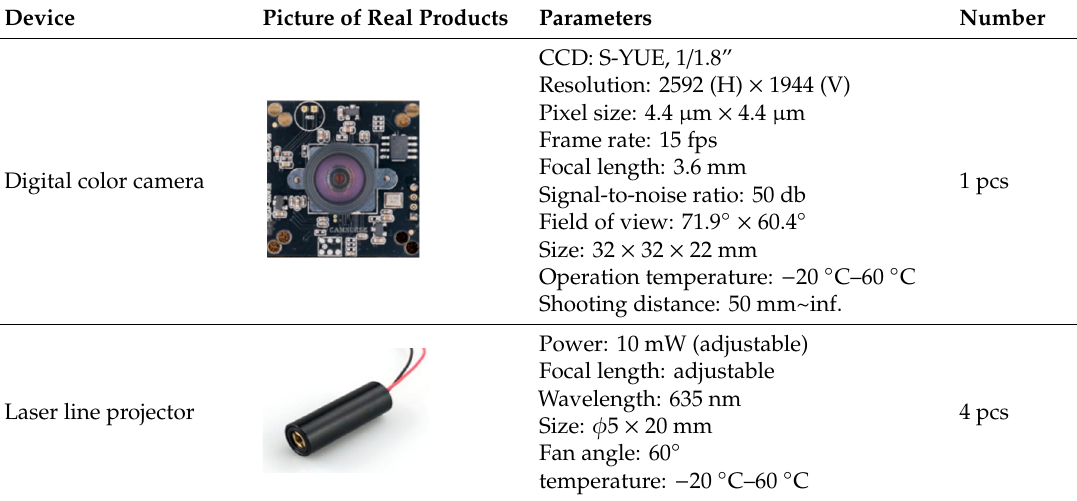
Table 1. Detailed parameters of the experimental equipment.